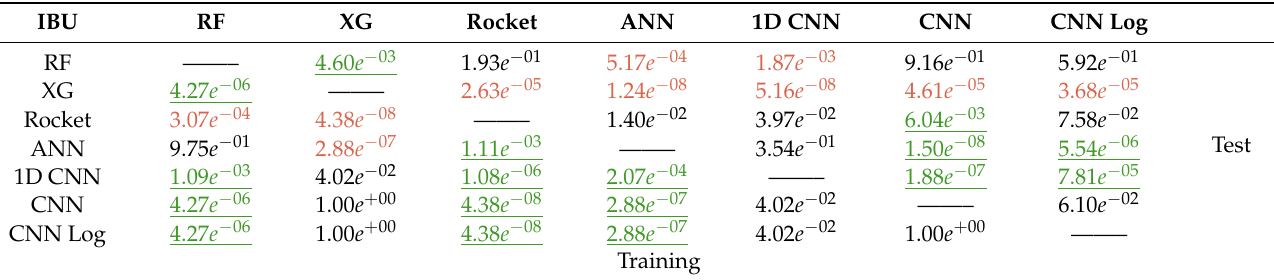
Table A5. Kruskal–Wallis p -values comparing all methods of the IBU concentration prediction task. Above the diagonal, we have the results for the test set, and below for the training set. Significant results ( p < 0.01) are represented in green or red when the method on the left is significantly better or worse, respectively.